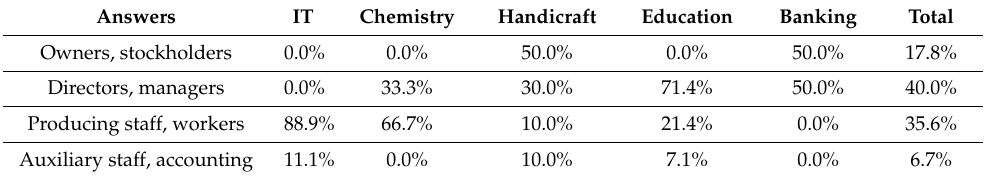
Table 9. Distribution of hierarchy positions of core human resources of